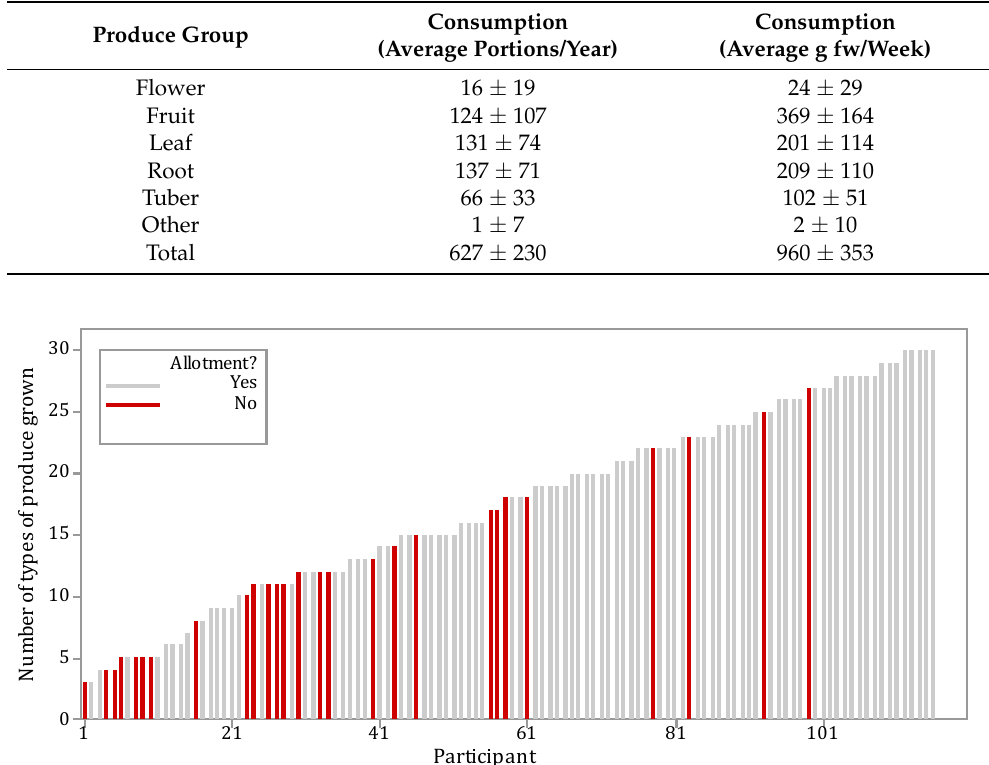
Figure 3. Number of types of produce grown per gardener surveyed. Two individuals did not grow produce whilst another two failed to respond to this section of the